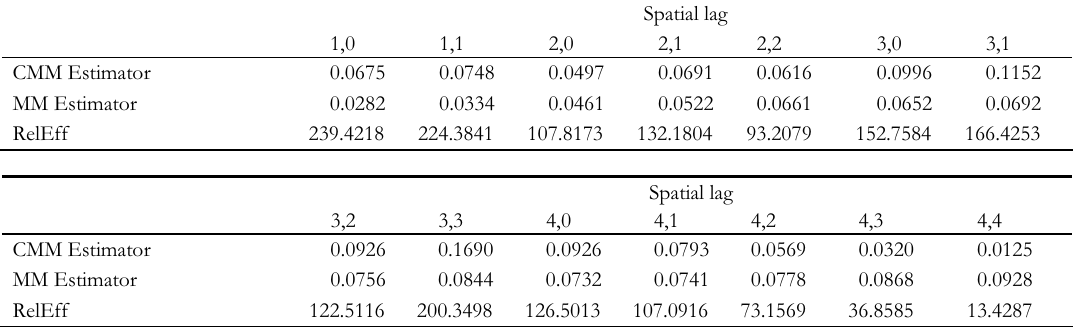
Root mean square errors for the classical (MM) and the corrected (CMM) method-of-moments estimators of spatial correlations at lags (1,0), ..., (4,4) under the strong dependency case. The relative efficiency between the considered estimators is reported using the RelEff statistic (see eq. (16)) Spatial